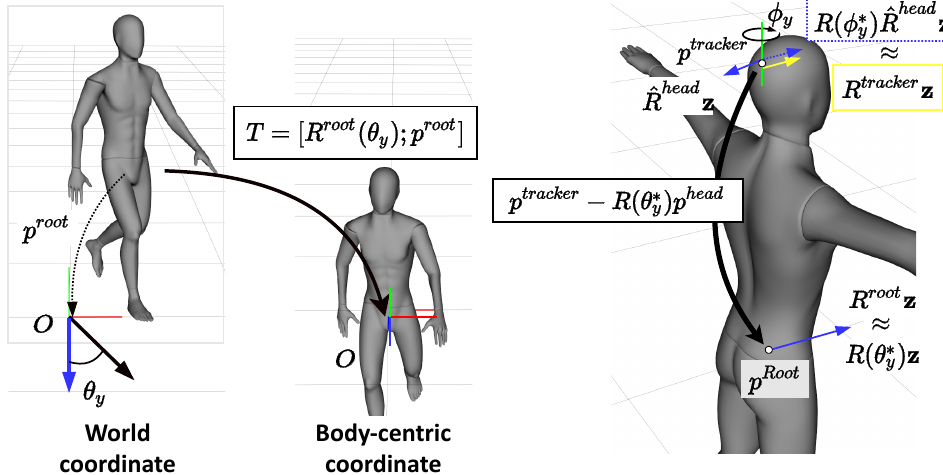
Figure 3. The coordination transformation: ( Left ) for training, we removed global information by transforming the real-world coordinates into the body-centric coordinates that identified the position of the frame at the root joint and the rotation about the y-axis was the direction of the root joint aligning to the z-axis; ( Right ) after the prediction, the global information had to be recovered, so the rotation φ ∗ y was computed by matching the tracker’s direction with the IMU that was attached to the head. With rotation R ( θ ∗ y ) , the position of the root joint could be computed from the head position using our